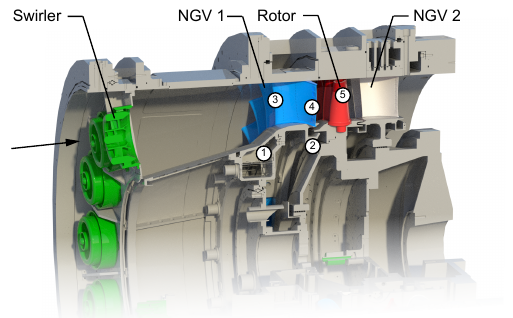
Figure 1. Large Scale Turbine Rig test section and operating